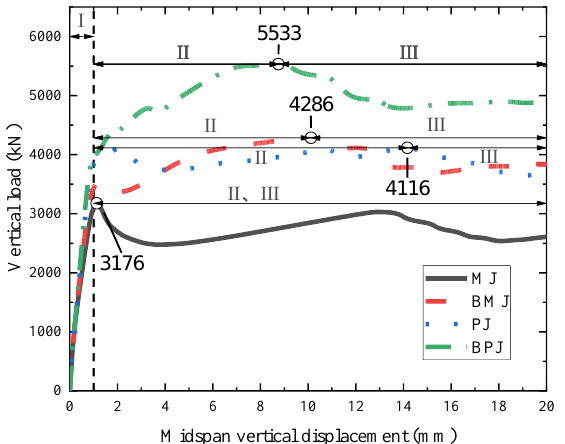
Figure 8. Load – displacement curves of the four joints at room temperature. Figure 8. Load–displacement curves of the four joints at room